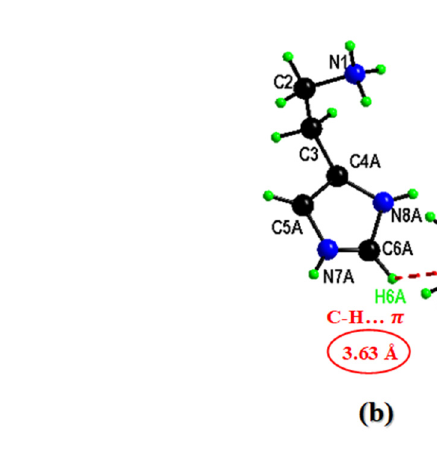
Figure 2. Representation of N–H… π ( a ) and C–H… π ( b ) interactions.